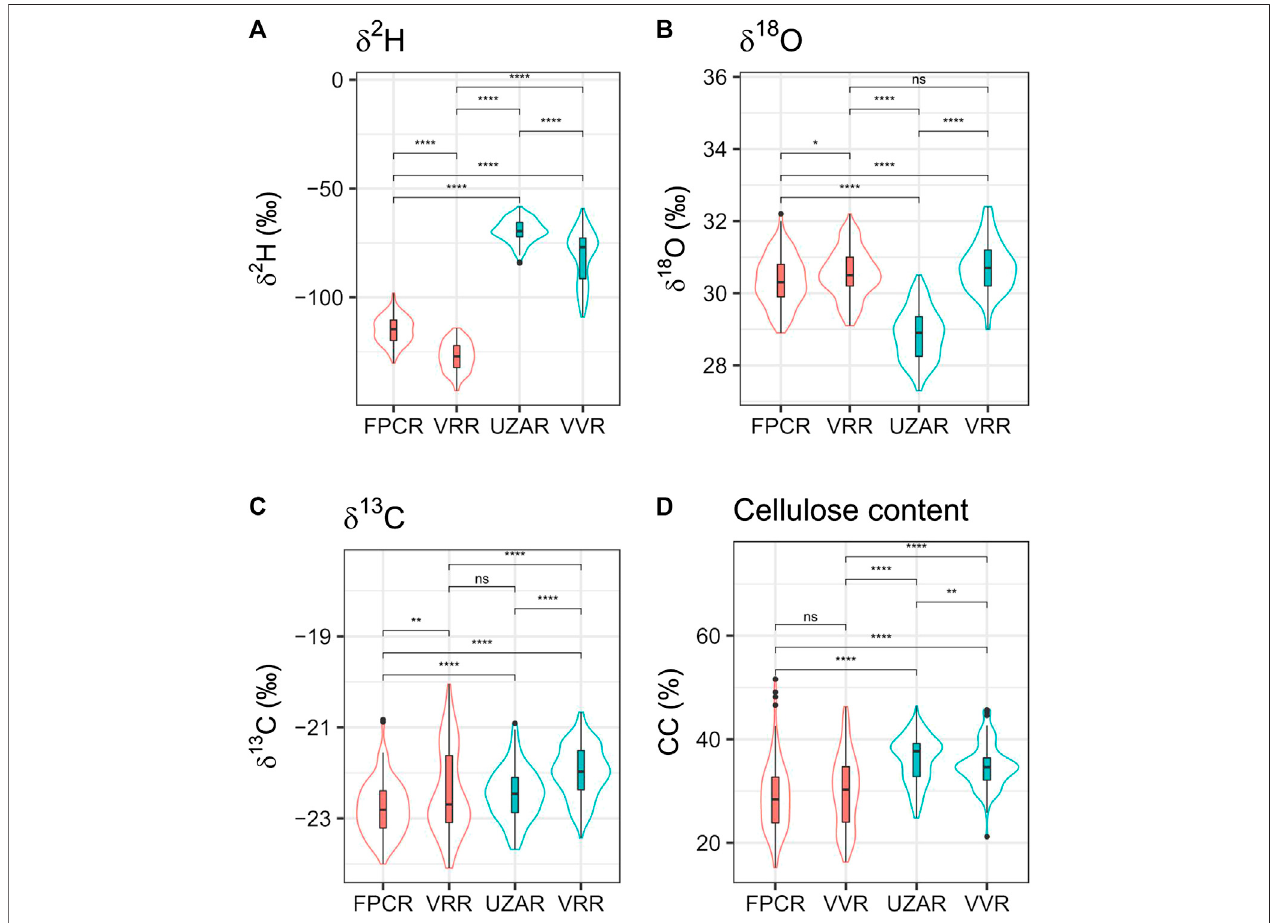
FIGURE2| IsotopesinthecelluloseoflivingtreesfromAlpinesites.Theyarepresentedasboxplotwithmedianandlimitsof90and95percentile,contouredbythe violinsplotsthatshowthedensitydistributionofthedataused(HintzeandNelson1998).Meanvaluesof δ 2 H, δ 13 O, δ 18 Candcellulosecontentofcembranpineandlarch treesdated1820 – 2010A.D.and collectedat three sitesintheAlps: Valley d ’ Hérens(FPCR), Val Roseg (VRR) andGrimselsee (UZAR). Thevaluesofeachsitearebased on four different trees whose wood has been sampled in blocks covering 5 years. At VRR both larch (red) and cembran pine (blue) were collected, while at FPCR and UZAR only one species was collected, respectively larch and cembran pine. The box plots show the median, SD and spread, the surrounding violin plot shows the sample density (Hintze and Nelson 1998). The statistical difference calculated with Wilcoxon test are indicated above the horizontal lines: ns, non-signi fi cant: p >